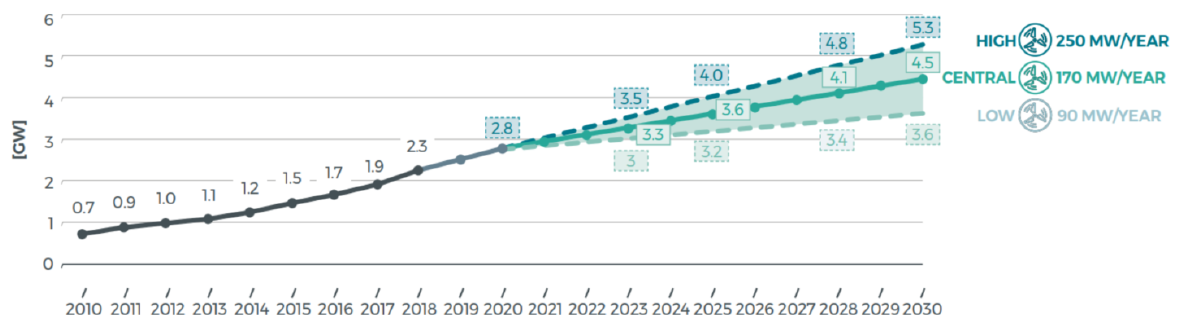
Figure 23. Historical and predicted values of onshore wind installed capacity in Belgium